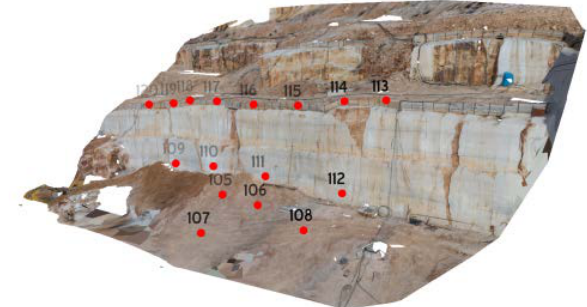
Figure 3. Control points location